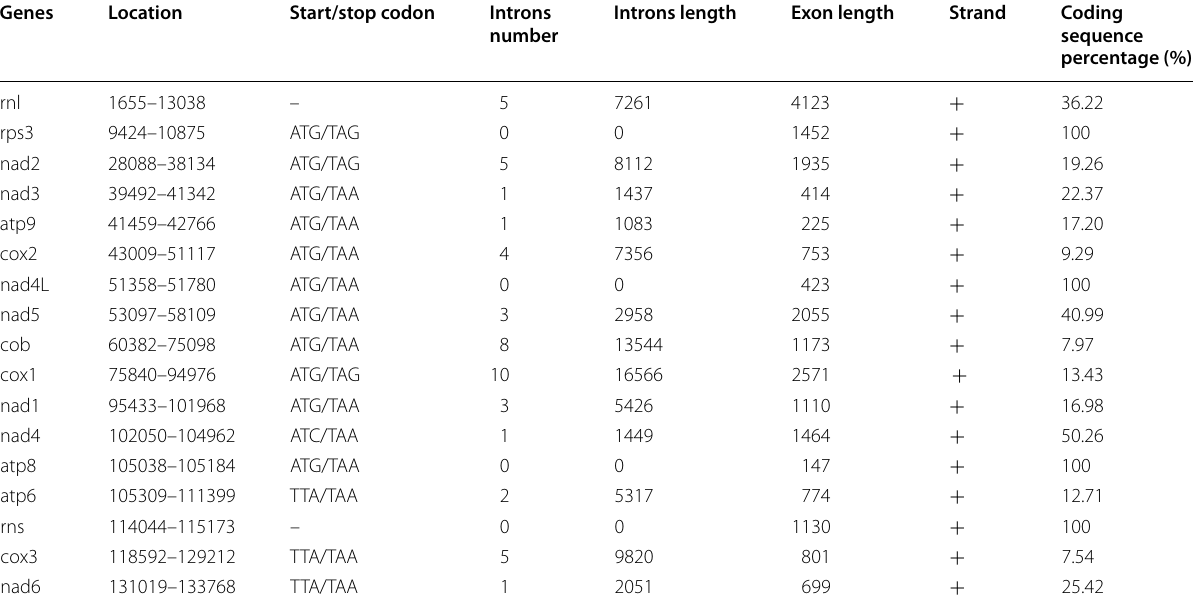
Table 2 PCGs and rRNA genes composition of Ophiocordyceps gracilis mitogenome Genes